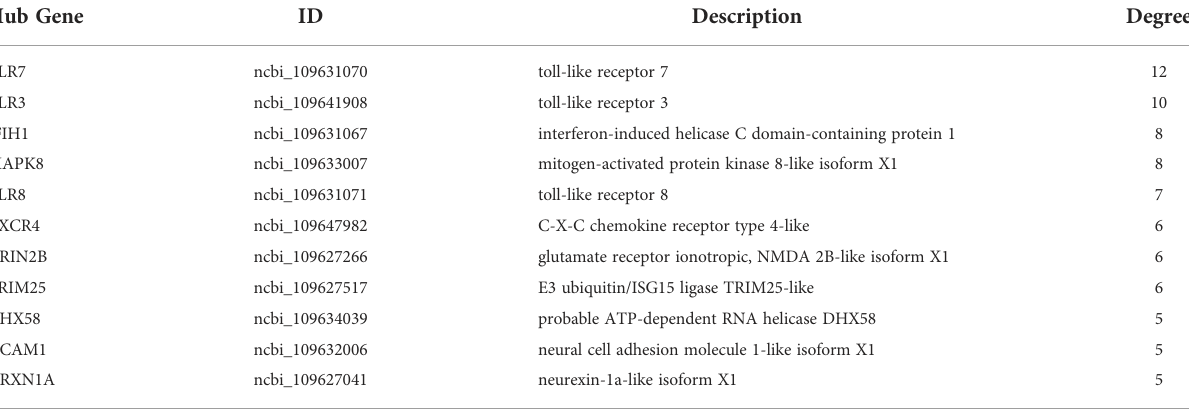
TABLE 9 Description and degree of connectivity of the 11 immune-associated upregulated hub genes on the fi rst day after challenge. Hub